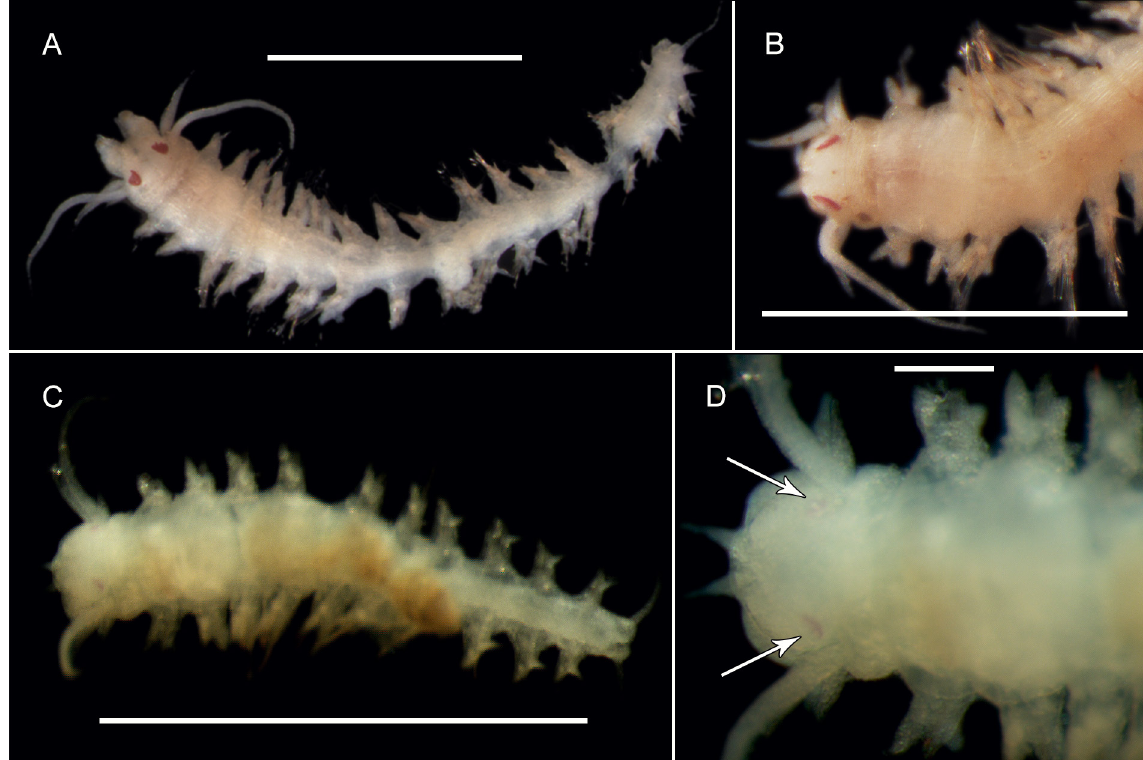
Fig. 5. Neanthes goodayi sp. nov., juvenile specimens. A . Paratype (1254), entire specimen, dorsal view. B . Paratype (NHM_171) dorsal anterior view. C . Paratype (NHM_127) entire specimen, dorsal view. D . Paratype (NHM_127), close up of dorsal anterior, arrows mark position of anterior eye pair. Scale bars: A, C = 1 mm; B = 500 µm; D = 100